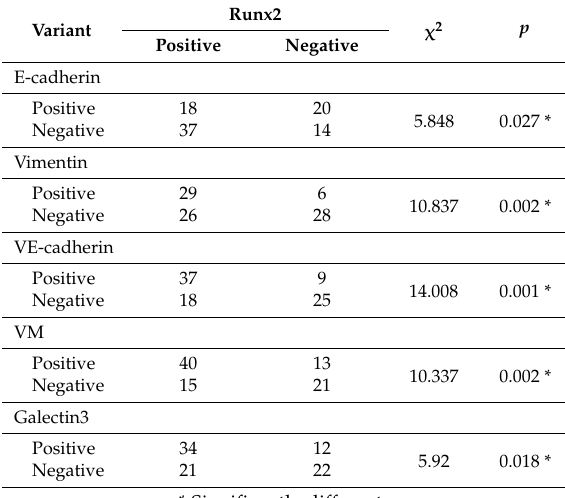
Table 2. Correlation between Runx2 expression with E-cadherin, Vimentin, VE-cadherin, VM, and Galectin-3.